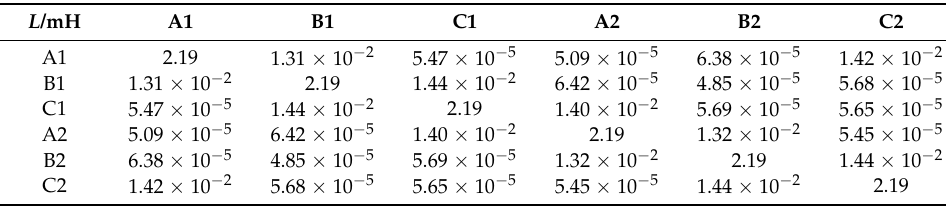
Table 2. The inductance matrix of the